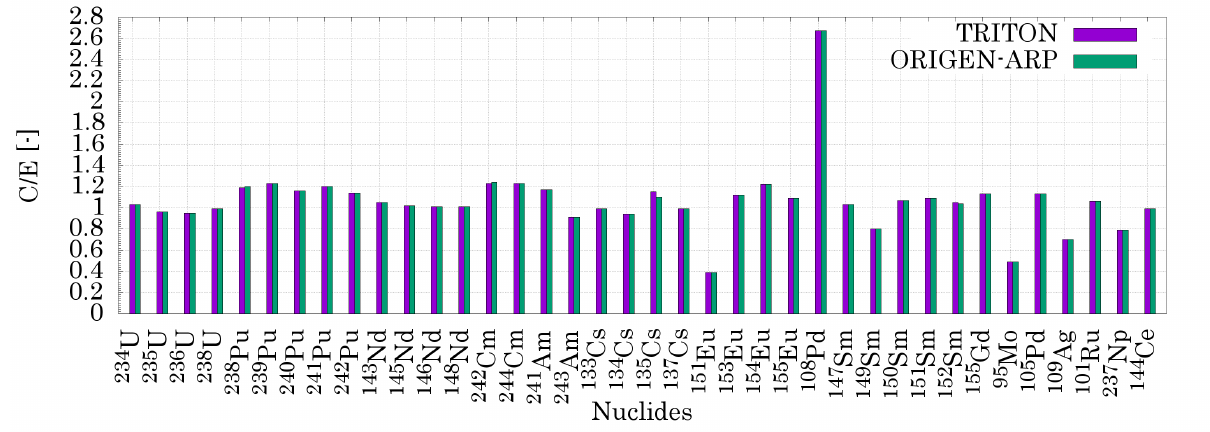
Figure 2. Comparison of calculated and experimental data